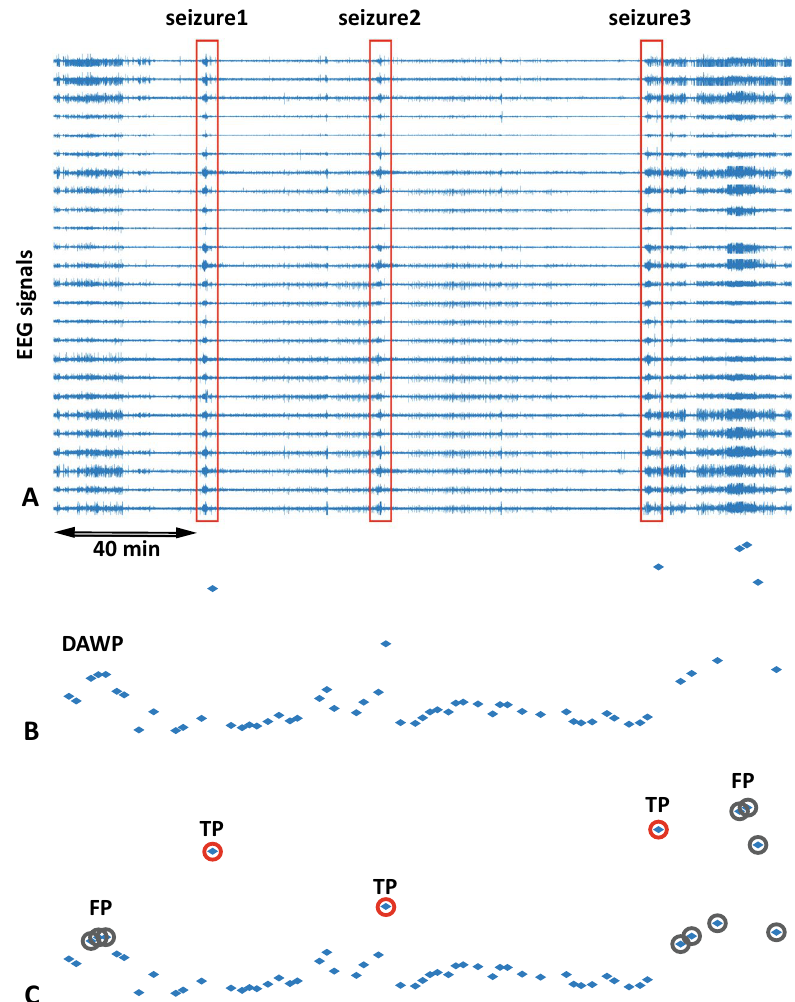
Figure 3. Example of data obtained at various steps of the algorithm: ( A ) EEG data (25 channels) with 3 epileptic seizures (shown as red frames); ( B ) result of WP averaging over the 2–5 Hz frequency range, 25 channels, 60-s time intervals; ( C ) result of ML training and testing with a number of correctly (TP) and falsely (FP) detected events (shown as red and grey circles